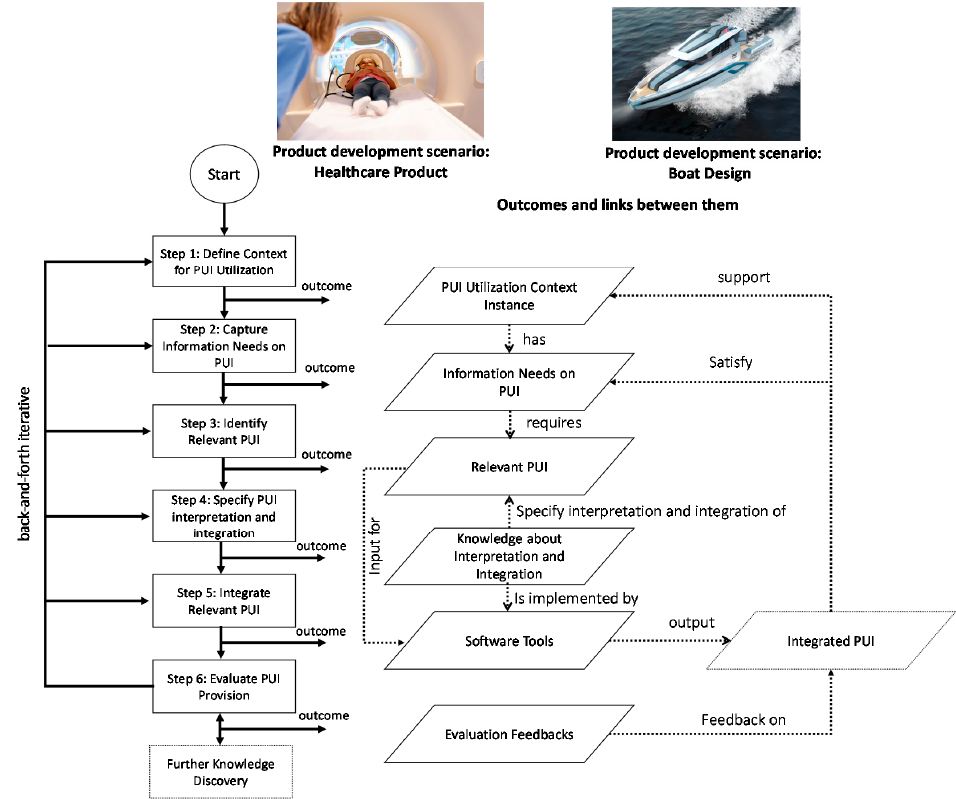
Figure 6. Overview of the steps in the application scenarios (healthcare products 1 and boat 2 ).